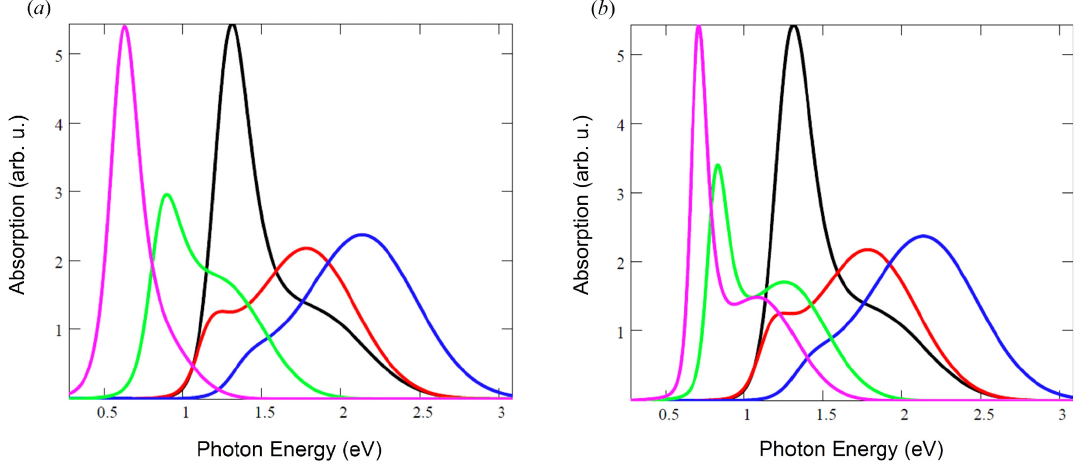
Figure 15. Transformation of the theoretical band shape for the two-photon absorption (Figure 14, red curve) with varying the reorganization energy E [1]. ( a ) γ ≡ constant = 0.34 eV ≡ γ red ;